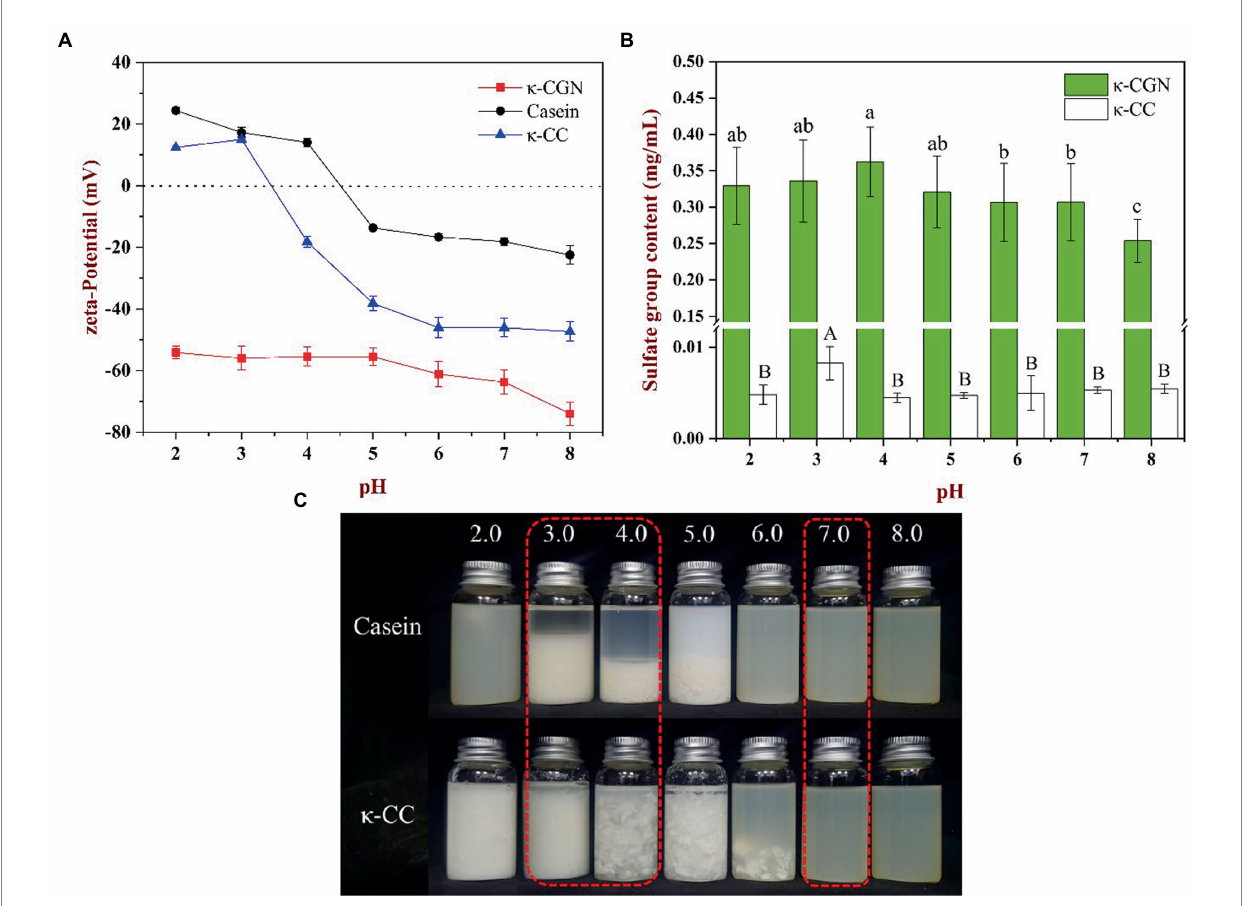
FIGURE 1 (A) The effect of pH on the zeta-potential of κ -CGN, casein and κ -CC complexes. (B) Free sulfate group content of the κ -CGN and κ -CC complexes at physiological pH in the simulated gastrointestinal phase. (C) Physical diagram of the κ -CGN and κ -CC complexes at physiological pH in the simulated gastrointestinal